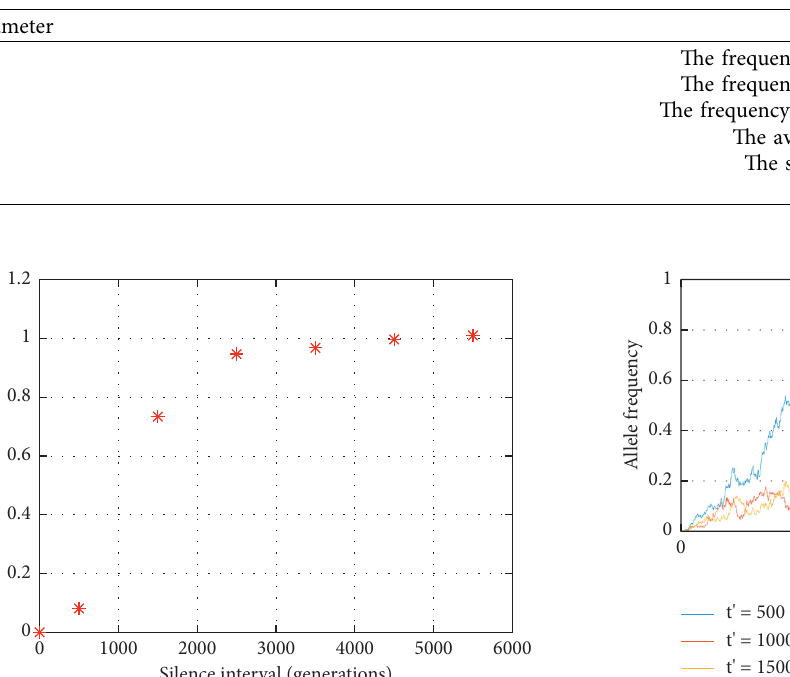
Figure 3: Evolution of the frequency of the focal allele A reaching fixation, starting from a single mutant with a silence time of 500, 1000, and 1500